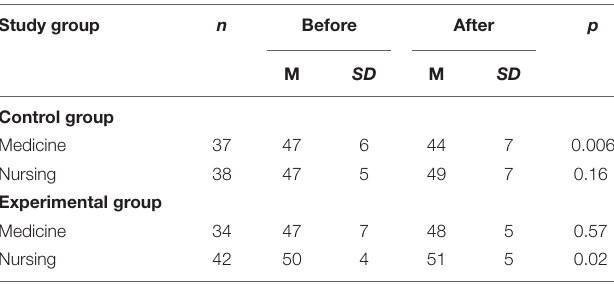
TABLE 3 | Summary result of Wilcoxon test of JSAPNC scores by study groups (experimental vs. control) before and after the study was performed. Study group